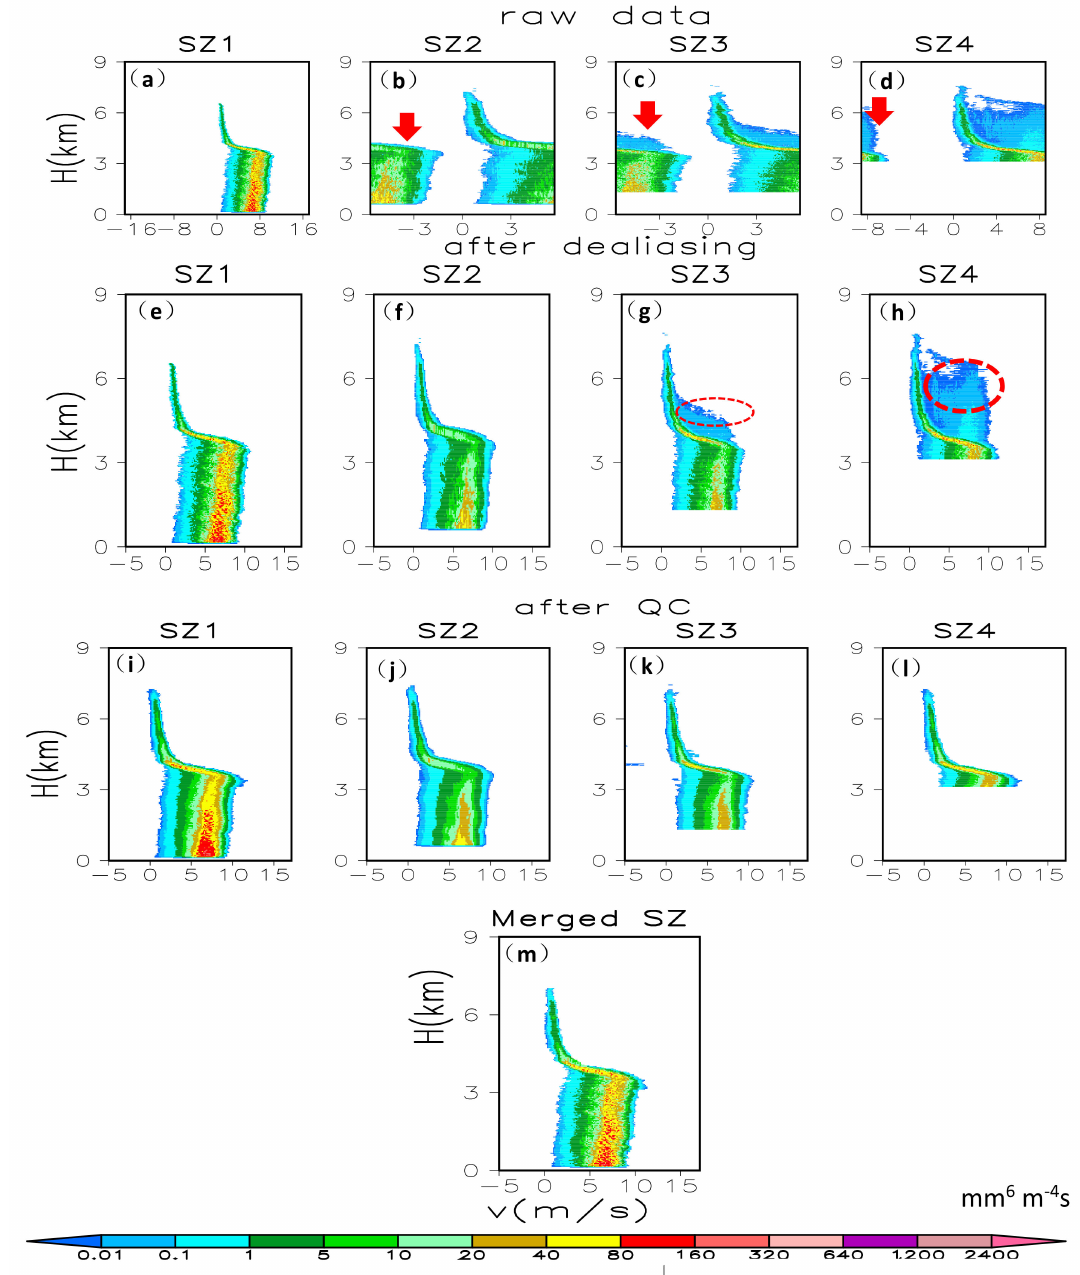
Figure 4. Raw reflectivity spectra across di ff erent heights for the 30th profile observed using operational modes ( a ) M1, ( b ) M2, ( c ) M3, and ( d ) M4, after dealiasing only ( e–h ) and QC data after dealiasing, artifact removal and attenuation correction ( i–l ). Merged data ( m ). The aliased parts of the reflectivity spectra are indicated by a red arrow, and range sidelobe artifacts are highlighted with red